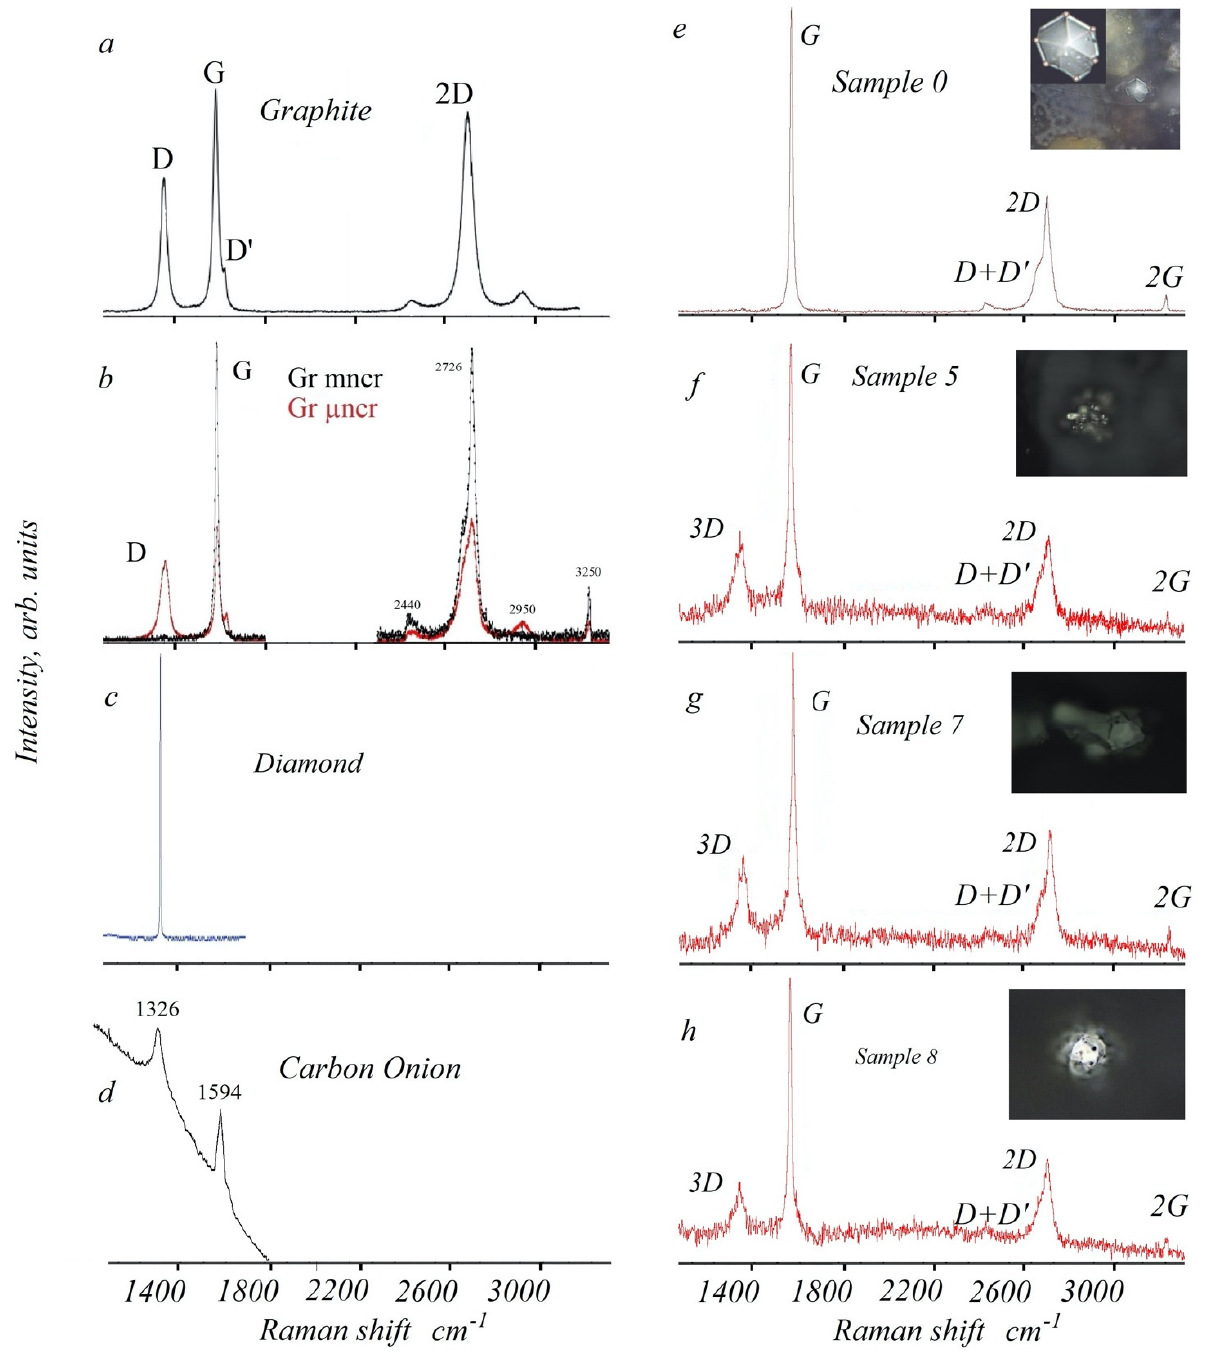
Figure 5. ( a ): Typical Raman spectrum of graphite; ( b ): Raman spectra of Mono- ( mncr ) (in black) and micronanocrystalline ( µ ncr ) (in red) graphites [21,27–29]; ( c ): Typical diamond Raman spectrum; ( d ): Raman spectrum of carbon onion [26] (Adapted with permission from Ref. [26], 2000, Elsevier). ( e ): Chelyabinsk superbolid ECM Sample 0 Raman spectrum. In the insert, a hexagonal particle from the center of Figure 1a bottom-right is presented; ( f ): Sample 5 Raman spectrum; ( g ): Sample 7 Raman spectrum; ( h ): Sample 8 Raman spectrum. The optical images of ECM particles (2000 magnification) are presented in the inserts for Chelyabinsk superbolid ECM samples.